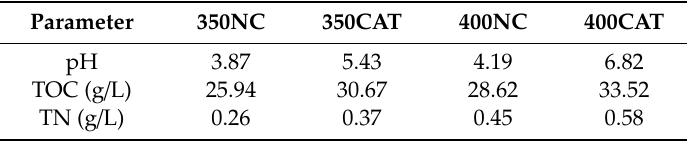
Table 5. pH, TOC, and TN in the aqueous